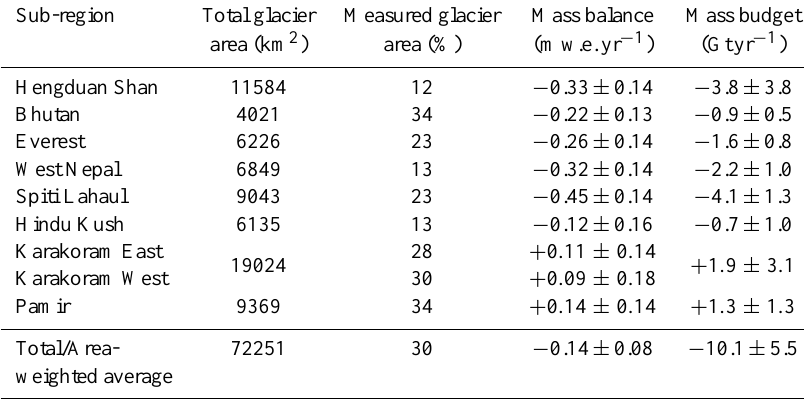
Table 4. Glacier mass budget of the nine sub-regions, to which the results of the study sites (mass balances) have been extrapolated. For each of them, the total glacierized area as well as the percentage of the glacier area over which the mass balance was computed (i.e. study sites) are given. The total glacier area is derived from the RGI v2.0 (Arendt et al., 2012). The error for the mass balance in each sub-region is the root of sum of squares (RSS) of the mass balance error of each study site and the regional extrapolation error. The error for the mass budget in each sub-region includes additionally the error from the total glacier area in the RGI v2.0.